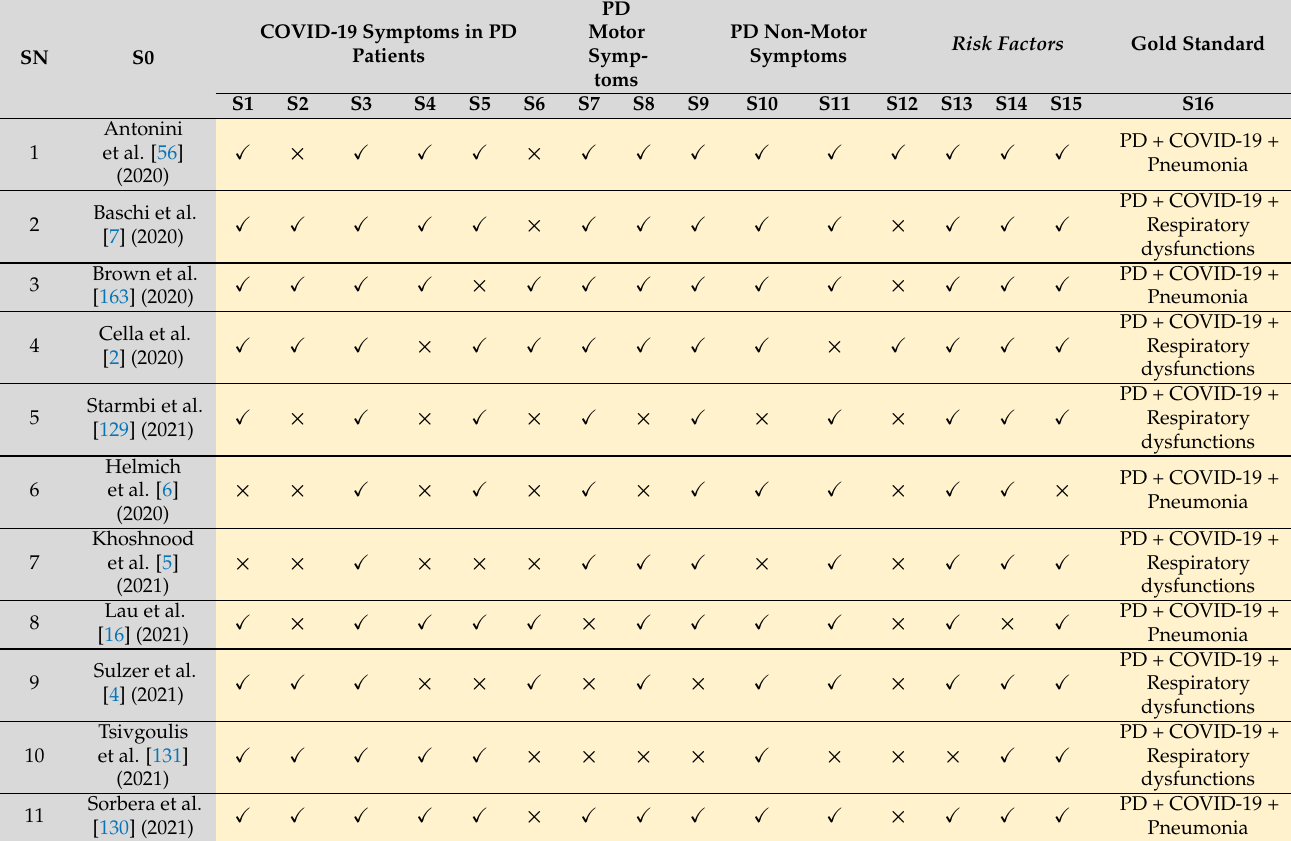
Table 7. Benchmarking scheme for selected